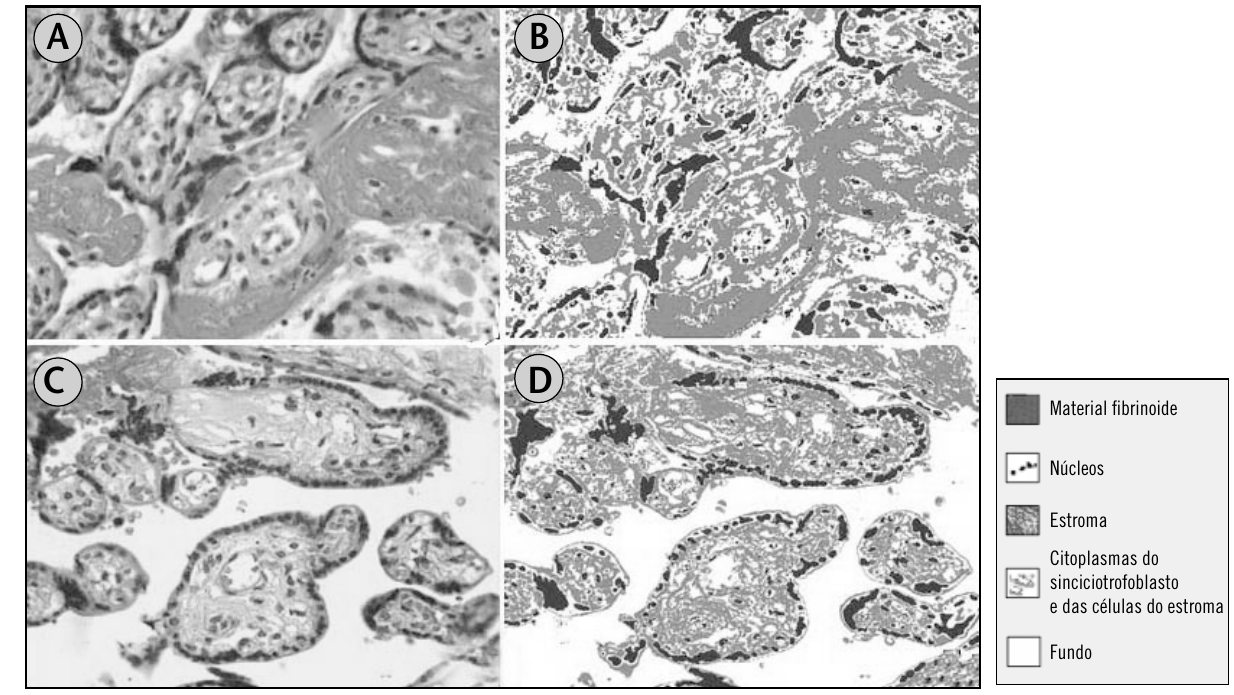
Figura 1 – (a) Imagem de placenta de gestação com pré-eclâmpsia (HE, 400 ×); (C) imagem de placenta de gestação sem pré-eclâmpsia (HE, 400 ×); (b e D) imagens segmentadas (ao lado de suas originais) para quantificação do material fibrinoide; núcleos; estroma; citoplasmas do sinciciotrofoblasto e das células estromais e do fundo Nota: ver o quadro de amostragem ao lado das imagens como substituição das cores originais na indicação das estruturas